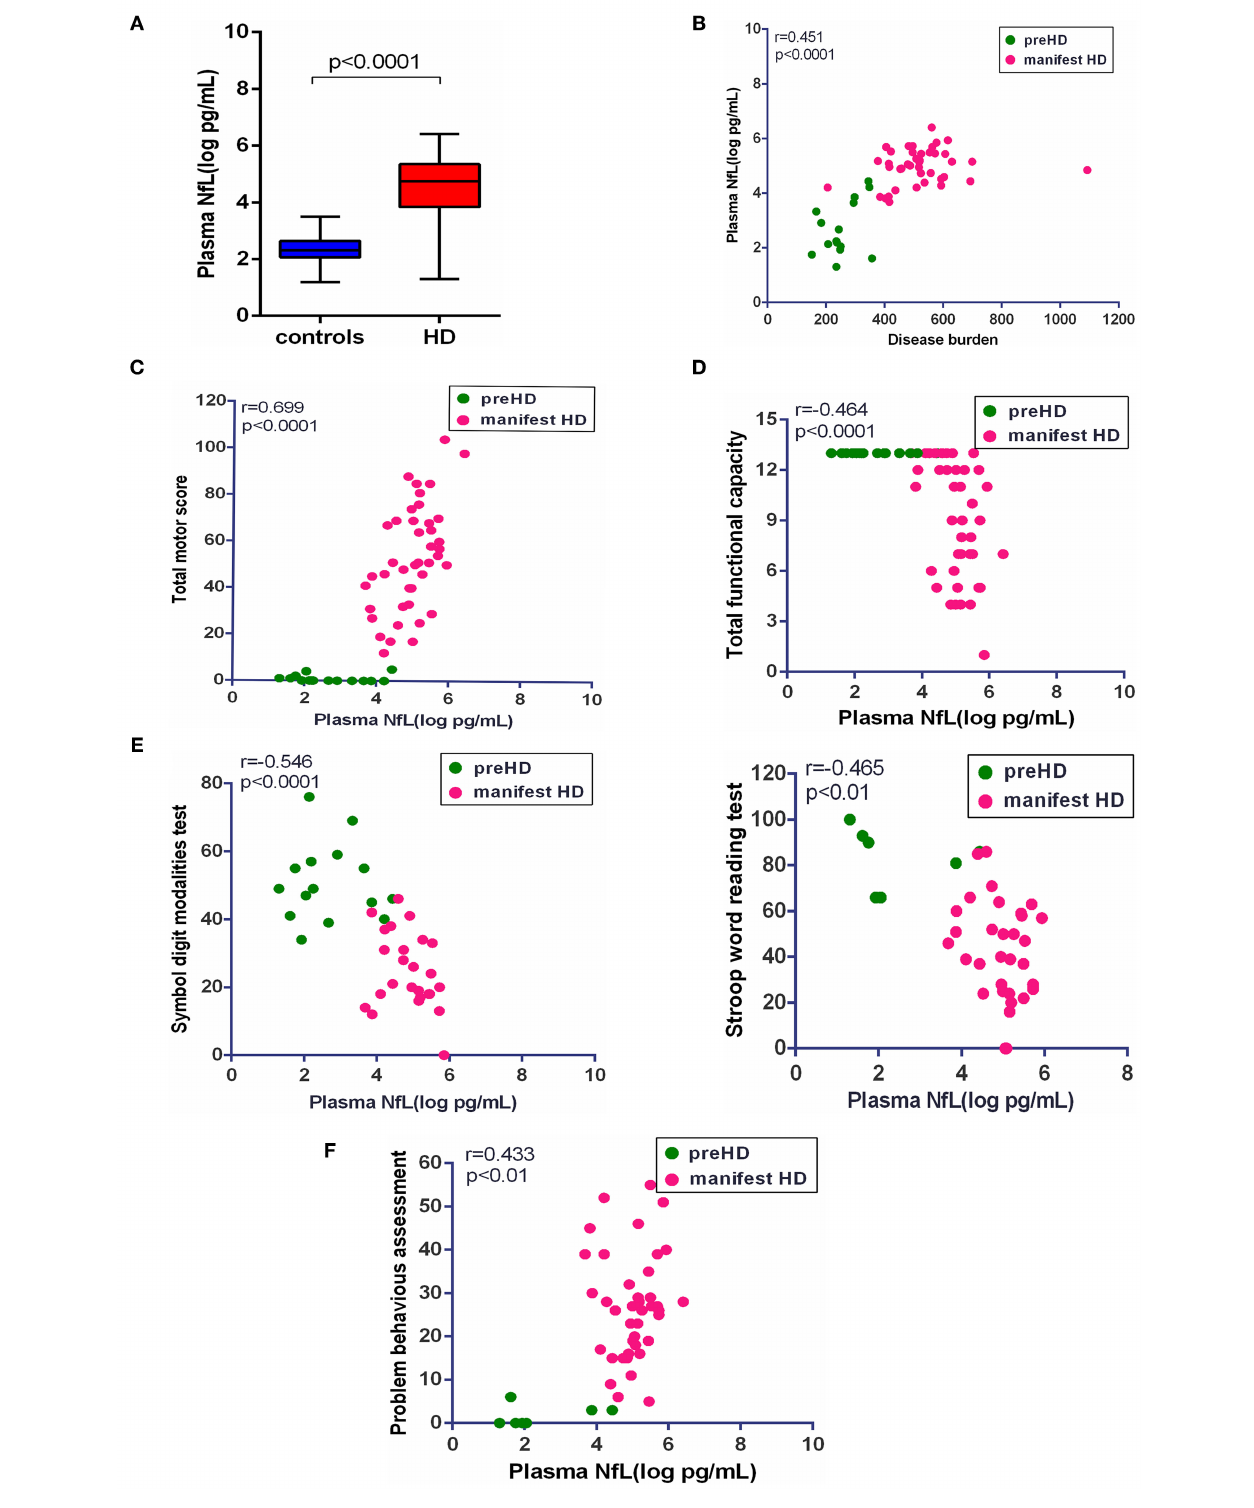
FIGURE 2 | Correlation of plasma NfL and clinical measures. (A) The concentration of plasma NfL in healthy controls ( n = 26) and HD mutation carriers ( n = 57). (B) Plasma NfL was significantly correlated with disease burden in HD mutation carriers. (C) Plasma NfL was significantly correlated with Total Motor Score in